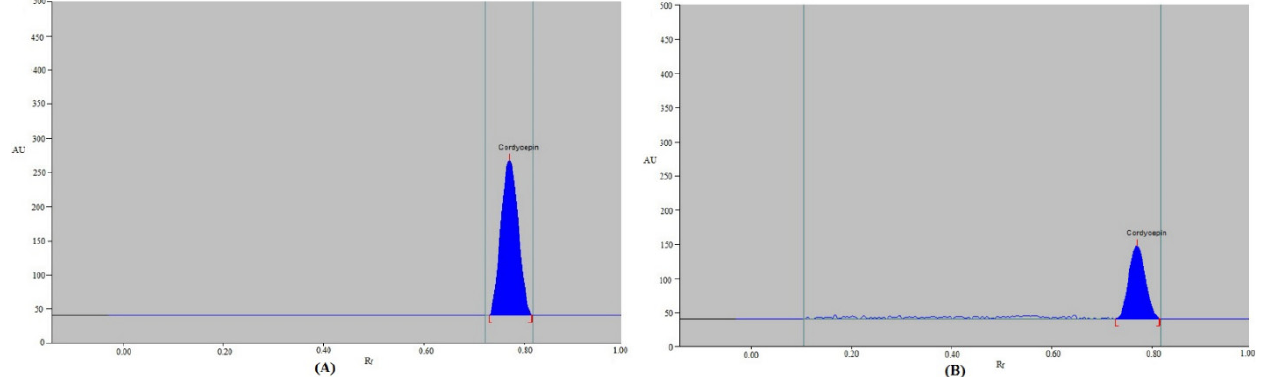
Figure 3. Representative chromatograms of ( A ) standard CDN and ( B ) CDN nanoemulsion for current protocol.